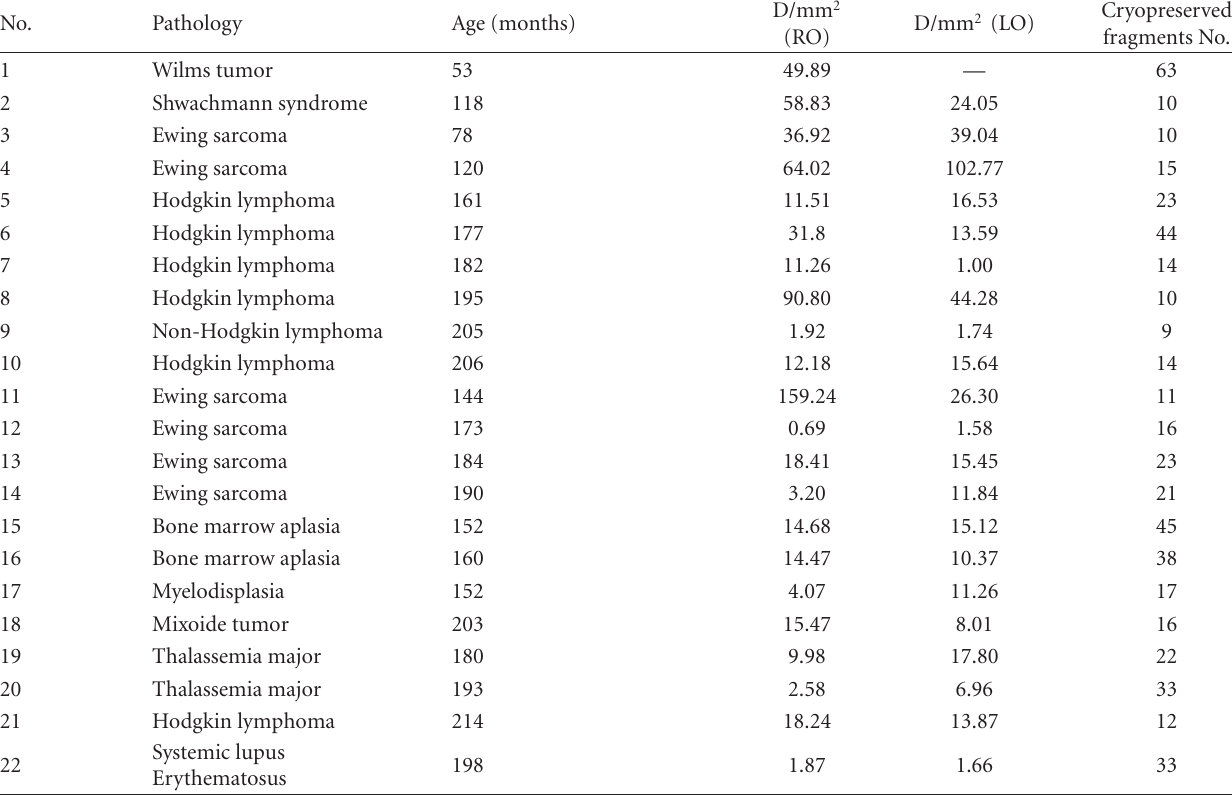
Table 2: Characteristics of the pre-chemotherapy patients who had ovarian tissue